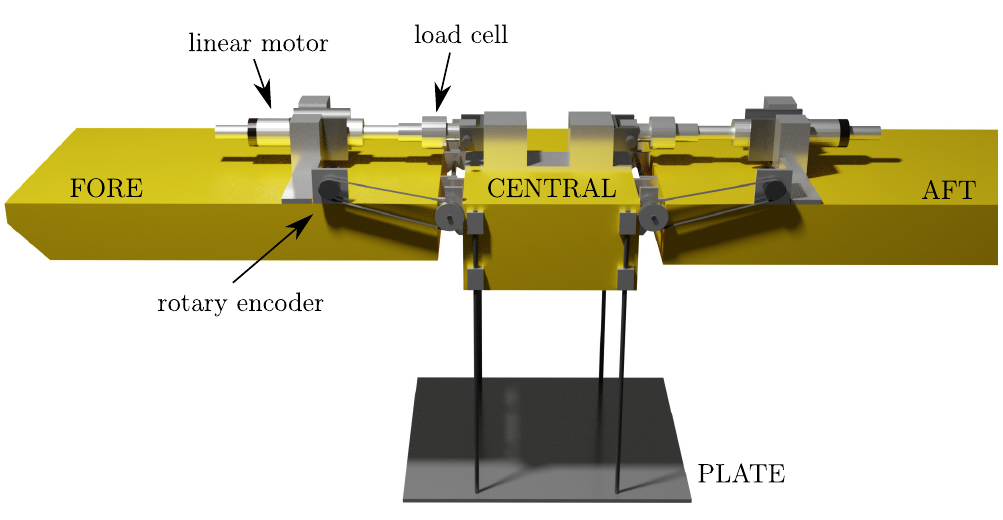
Figure 3. CAD rendering of the three-body hinge-barge wave energy